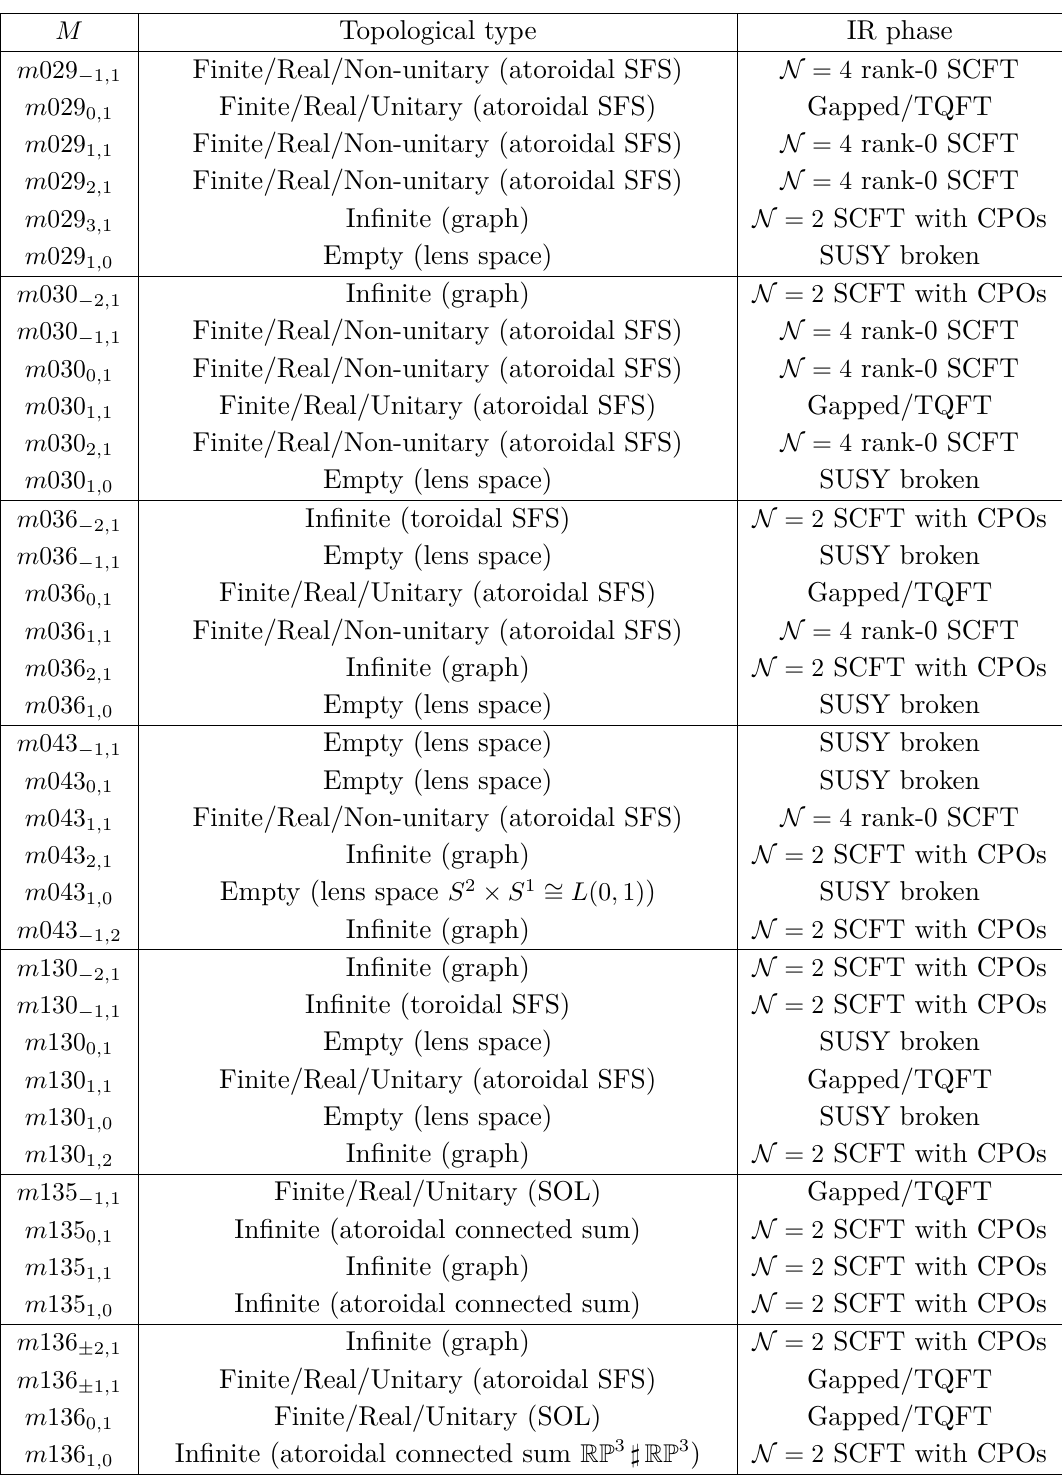
Table 3. Topological types of non-hyperbolic 3-manifolds obtained by exceptional Dehn fillings and the IR phases for the associated class R theories. Here N . Refer to [8] for the topological types of the non-hyperbolic 3-manifolds in the N PA SP + QB SP conventional mathematical classification scheme ( continues